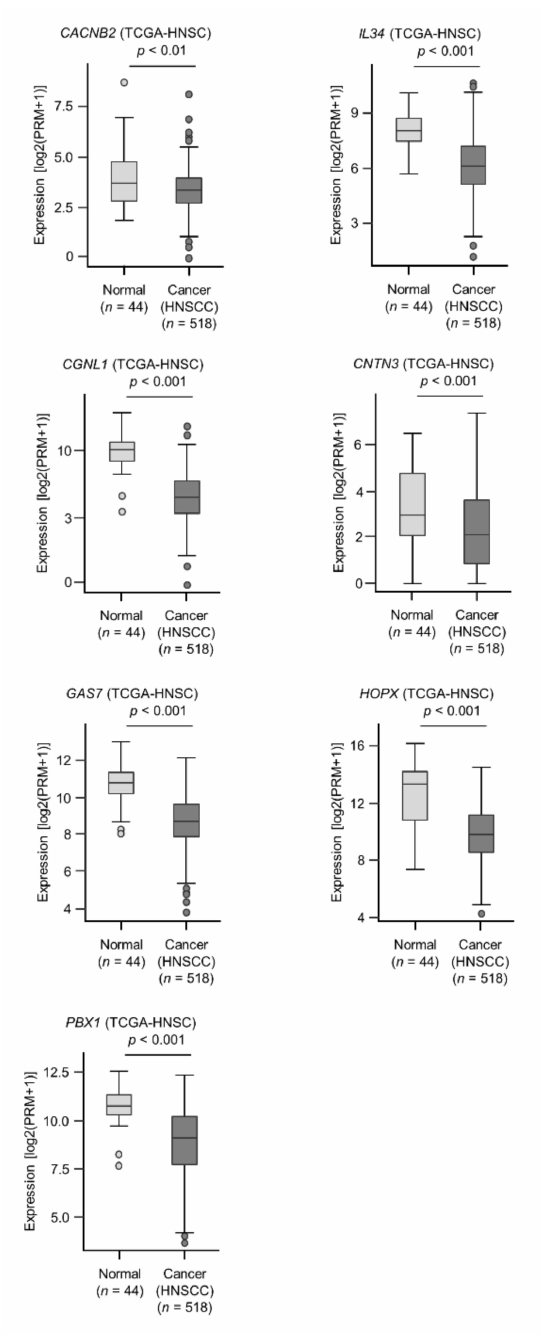
Figure 4. Expression levels of seven target genes ( CACNB2, IL34, CGNL1, CNTN3, GAS7, HOPX, and PBX1 ) in HNSCC clinical specimens from TCGA-HNSC. All genes were found to be downregulated in HNSCC tissues ( n = 518) compared with normal tissues ( n =